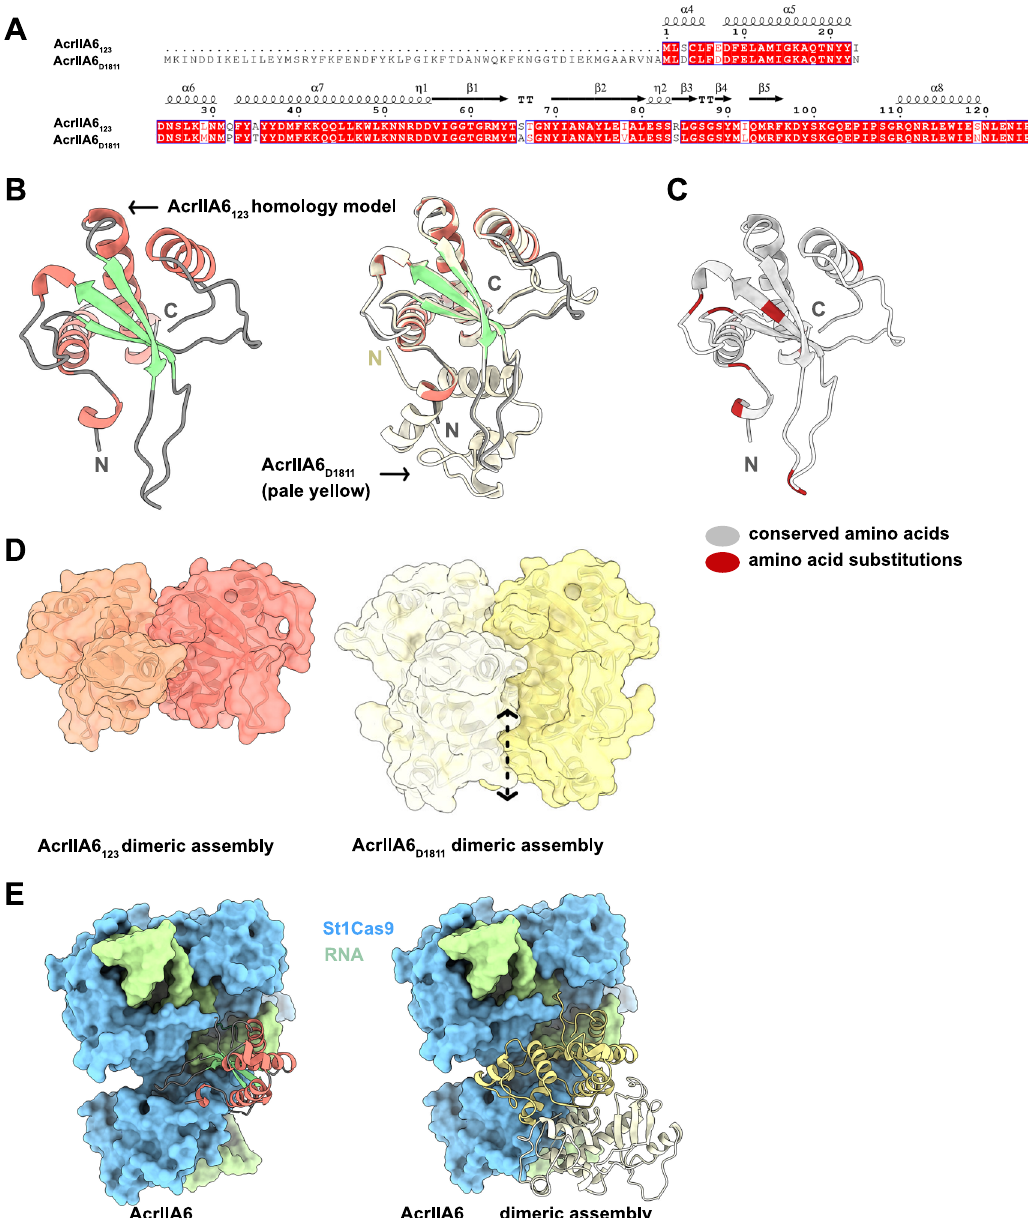
Fig. 4 Homology model of AcrIIA6 123 . A Sequence alignment of AcrIIA6 123 and AcrIIA6 D1811 (residues 59 – 183). Secondary structure elements from the crystal structure of AcrIIA6 D1811 are shown above the alignment. B Ribbon representation of the AcrIIA6 123 homology model (left, colors representing secondary structure elements) superimposed on the crystal structure of AcrIIA6 D1811 (right, pale yellow). C Representation of sequence variations between AcrIIA6 123 and AcrIIA6 D1811 . Gray areas represent 100% sequence identity. Red patches represent amino acid substitutions. D Surface representations of AcrIIA6 123 (left) and AcrIIA6 D1811 (right) dimeric assemblies. The dotted arrow indicates the dimerization interface missing in the AcrIIA6 123 dimer. E Comparison between the simulated binding interface of AcrIIA6 123 to St1Cas9-RNA complex (left) and the experimentally demonstrated binding of AcrIIA6 D1811 to St1Cas9-RNA complex